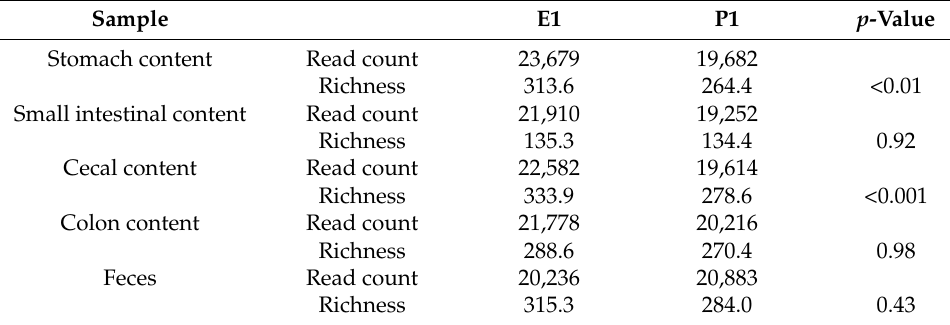
Table 1. Read count and α -diversity (richness) in trial 1.